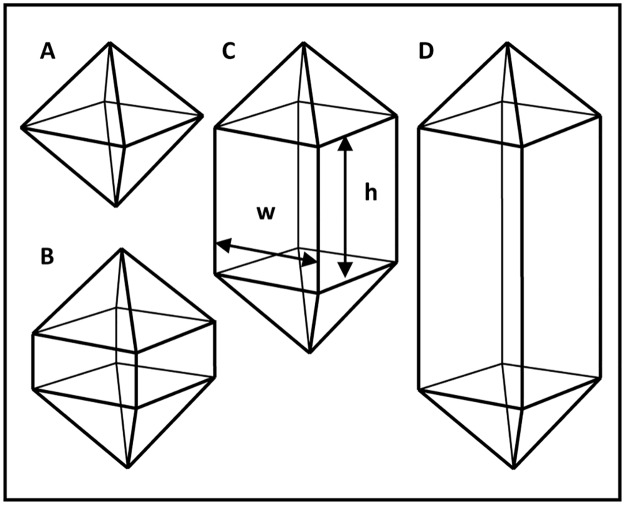
Classification of tetragonal crystals according to their aspect ratio (AR).AR was assessed as the ratio of width to height. A and B: bipyramidal with AR > 5. C: short rod with AR between 5 and 0.5. D: long rod, AR < 0.5.